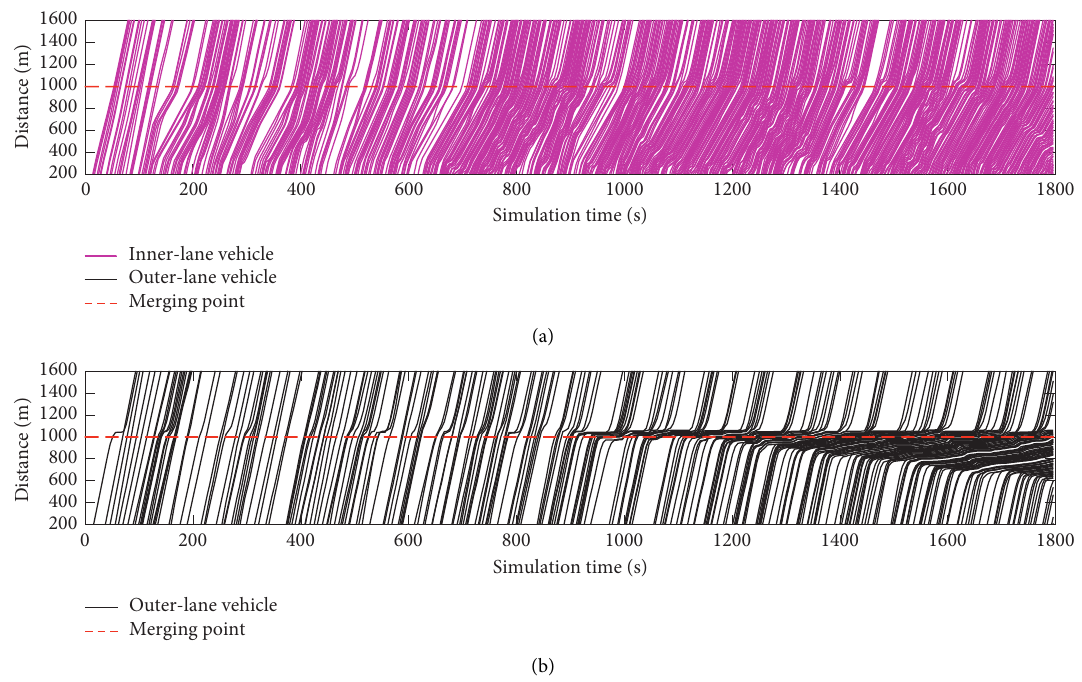
Figure 11: Scenario 1 vehicle trajectories. (a) Inner-lane vehicle trajectories. (b) Outer-lane vehicle